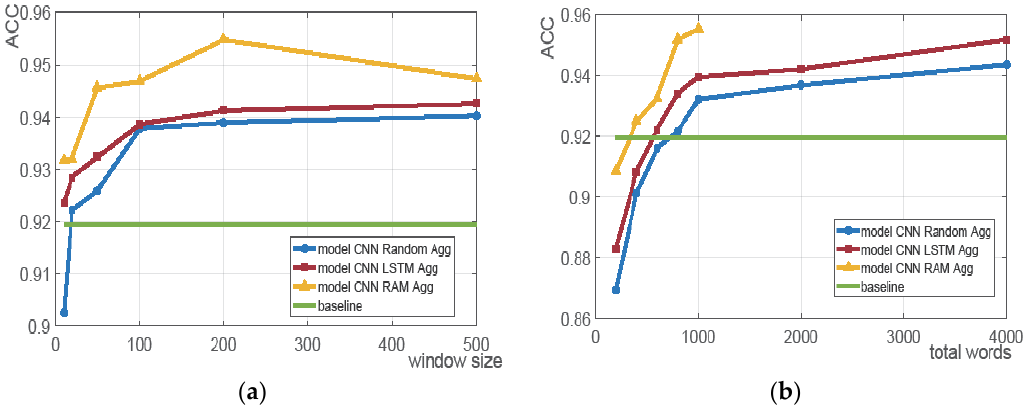
Figure 5. Experimental results of these models (ACC is the accuracy of classification): ( a ) Fixing the number of extracted words to 1000, vary the window size; ( b ) Fixing the window size to 40 words, vary the total number of extracted words.